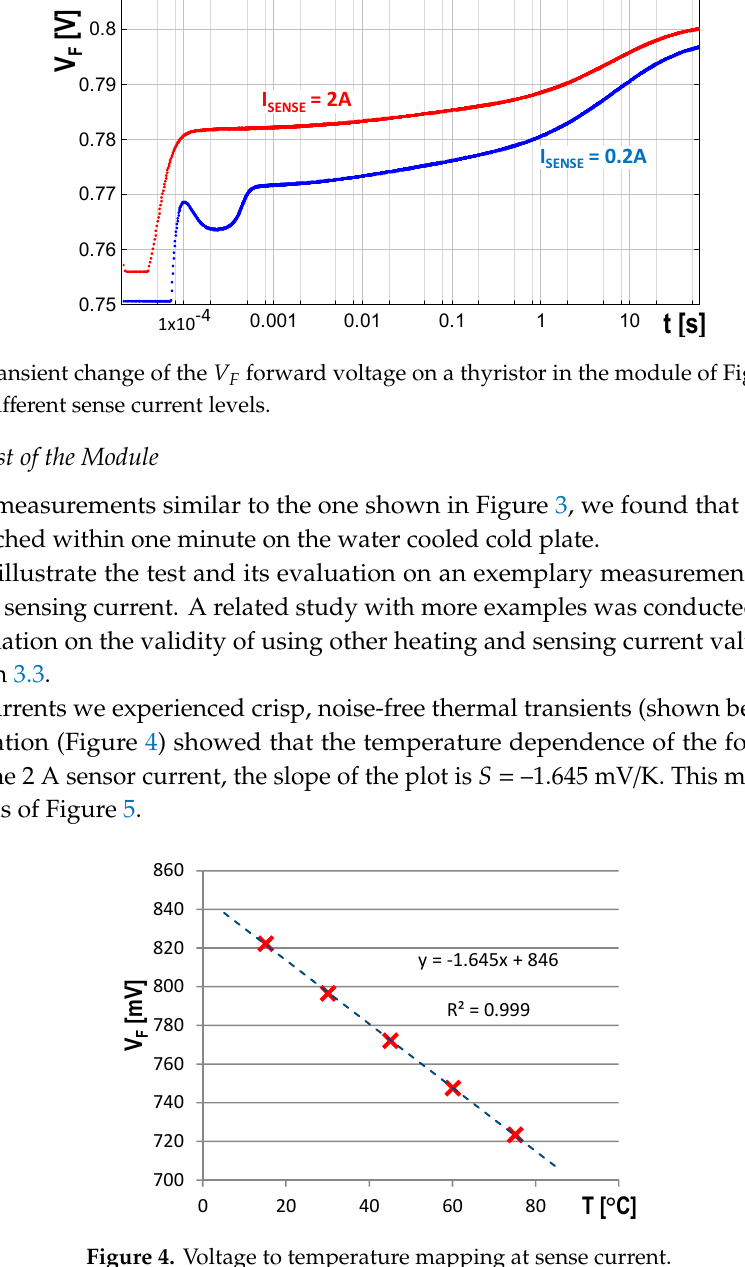
Figure 4. Voltage to temperature mapping at sense current.